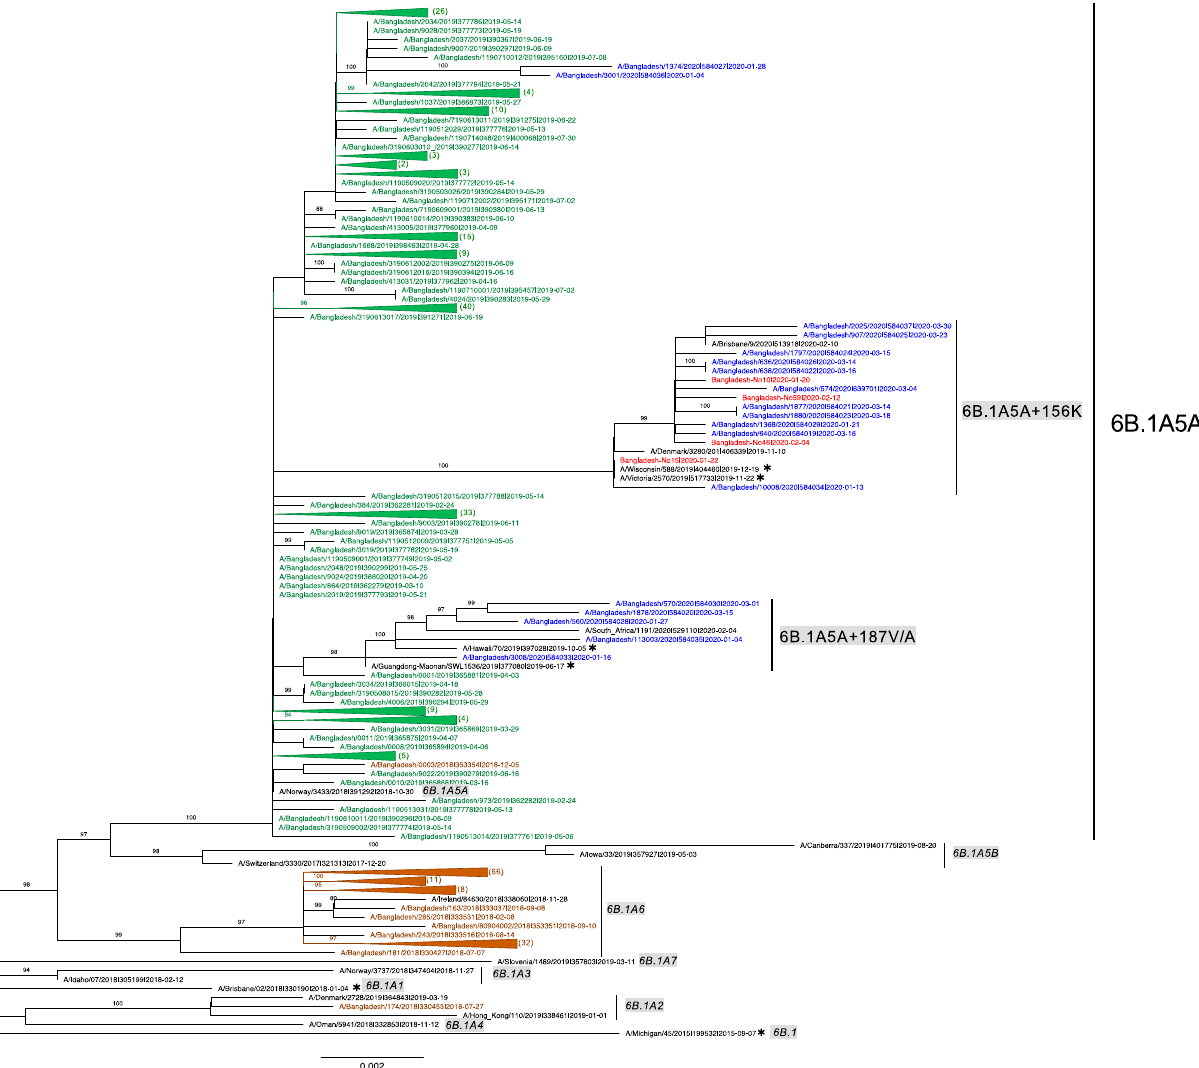
Figure 2. The H1N1pdm09 subclade in Bangladesh in 2018 to 2020. A maximum-likelihood tree of H1N1pdm09 was generated based on the HA gene with TVN+F+G4 and 1000 ultrafast bootstrap replicates using IQ-TREE. The percentage of trees (>80) in which the associated taxa clustered together is shown on the branches. The tree is drawn to scale, with branch lengths being directly proportional to the number of substitutions per site. Nucleotide sequences of the HA genes retrieved from EpiFlu GISAID are labeled as follows: isolate name|isolate ID|collection date. The Bangladesh 2018, 2019, and 2020 sequences are shown in brown, green, and blue, respectively, and the number of collapsed sequences is shown in parentheses at the end. The four sequences obtained in the present study are shown in red. The H1N1pdm09 subclade reference sequences are shown in black, with the subclade names highlighted in gray at the end. Subclade ranges are shown by vertical bars. Asterisks indicate the vaccine